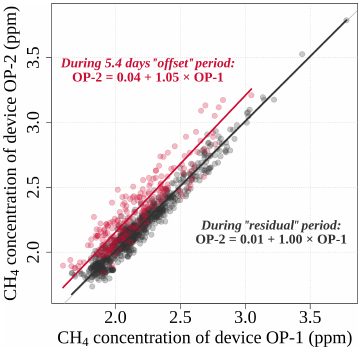
Figure 5. Scatter plot of 30min data from OP-1 and OP-2 recorded during campaign A18. Deming regression lines and corresponding regression equations are shown for the offset period and the remain- ing (“residual”)